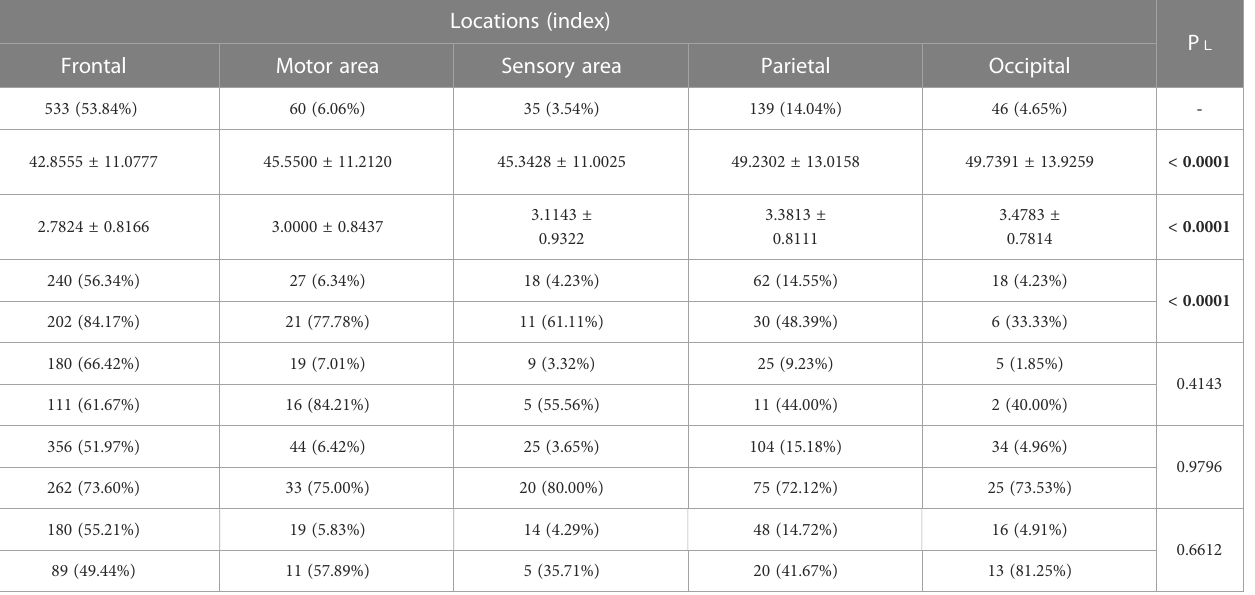
TABLE 2 Anterior-posterior trends in age and pathological